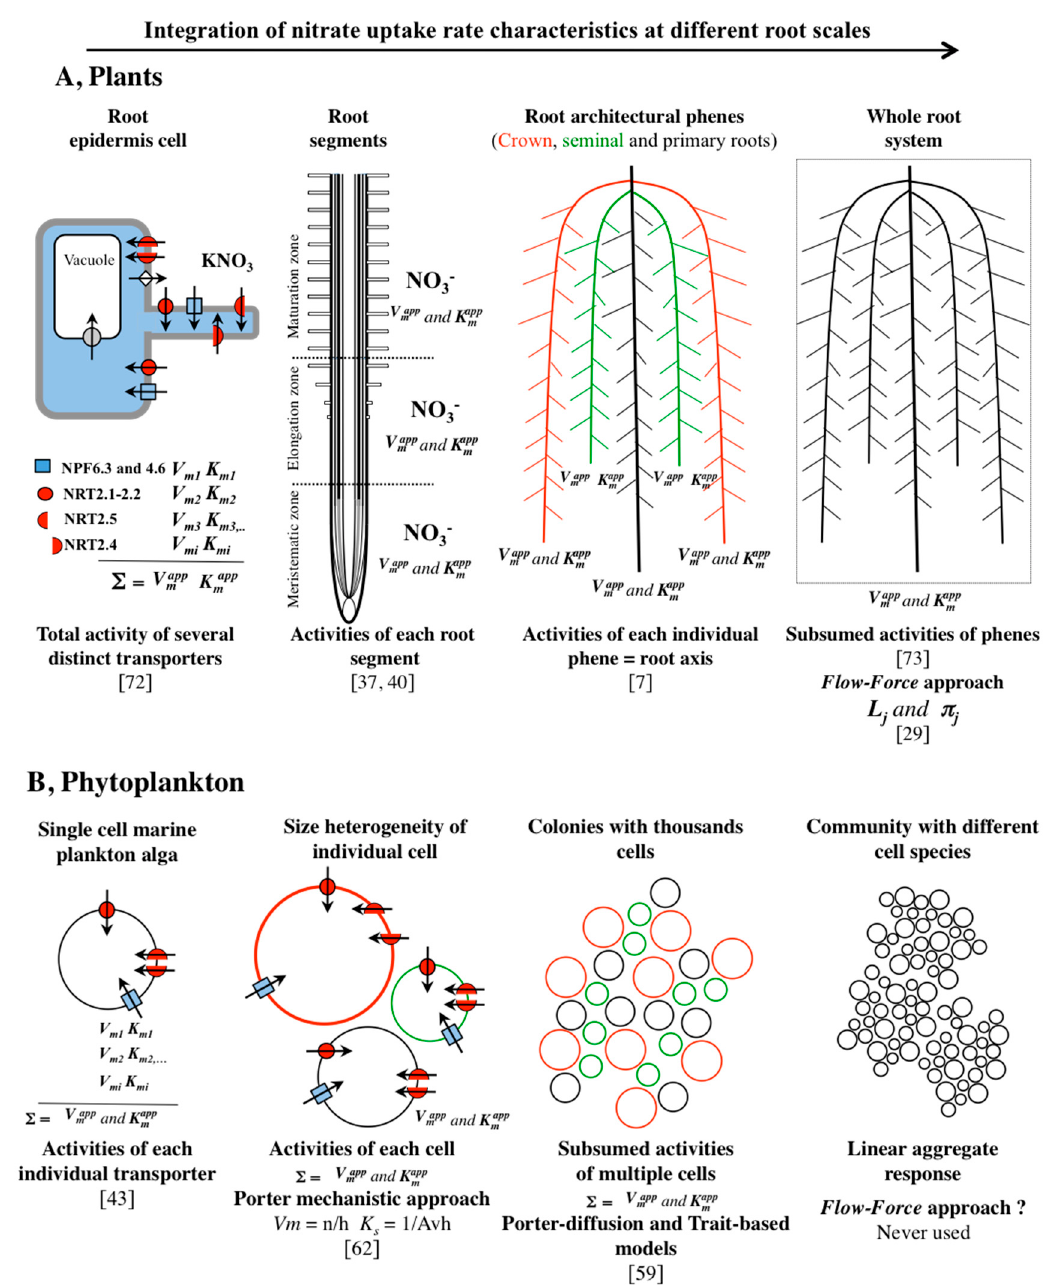
Figure 5. Integration of kinetic parameters for the nitrate uptake rate at different biological scales. ( A ) From the root epidermis to the whole root system in plants. ( B ) From individual cell to colony and community in marine phytoplankton. In the MM equation: V mapp , is the apparent maximum velocity, K mapp and K s are the apparent half-saturation constants. In the porter–diffusion equation: A is the area of one uptake site, n is the number of ion uptake sites per cell, v is the mass transfer coefficient, h is the handling time per ion on an uptake site.